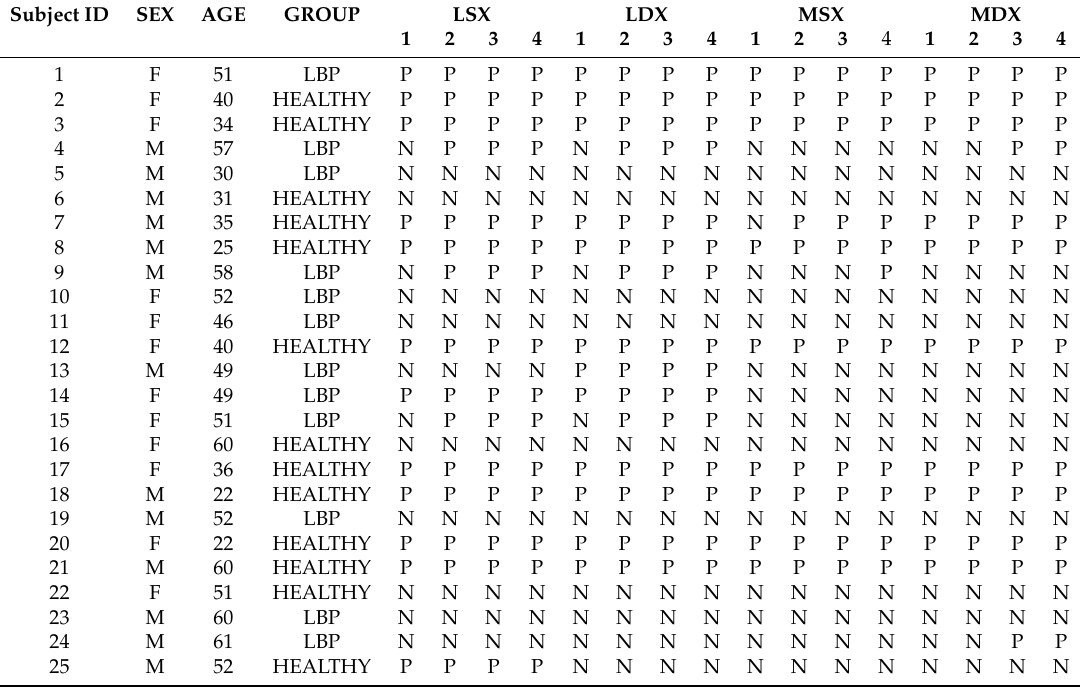
Table 1. Results of the VIS method. For each subject, the cycles of each channel are classified as Positive (P) or Negative (N)